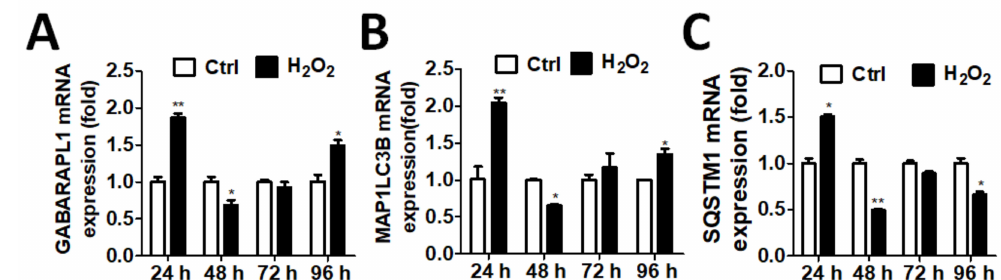
Figure 2. The mRNA levels of autophagy-related genes in adult retinal pigment epithelial (ARPE-19) cells during oxidative stress. ARPE-19 cells were treated with H 2 O 2 (250 µ M) for 24 h. The mRNA levels of ( A ) gamma-aminobutyric acid receptor-associated protein-like 1 (GABARAPL1), ( B ) microtubule-associated proteins 1A/1B light chain 3B (MAP1LC3B) and ( C ) SQSTM1 were determined by real-time PCR. The results were analyzed using Prism 5.0. The quantitative results are expressed as the mean ± SD from three independent experiments. * p < 0.05, ** p < 0.01 Cells treated with H2O2 vs. cells without